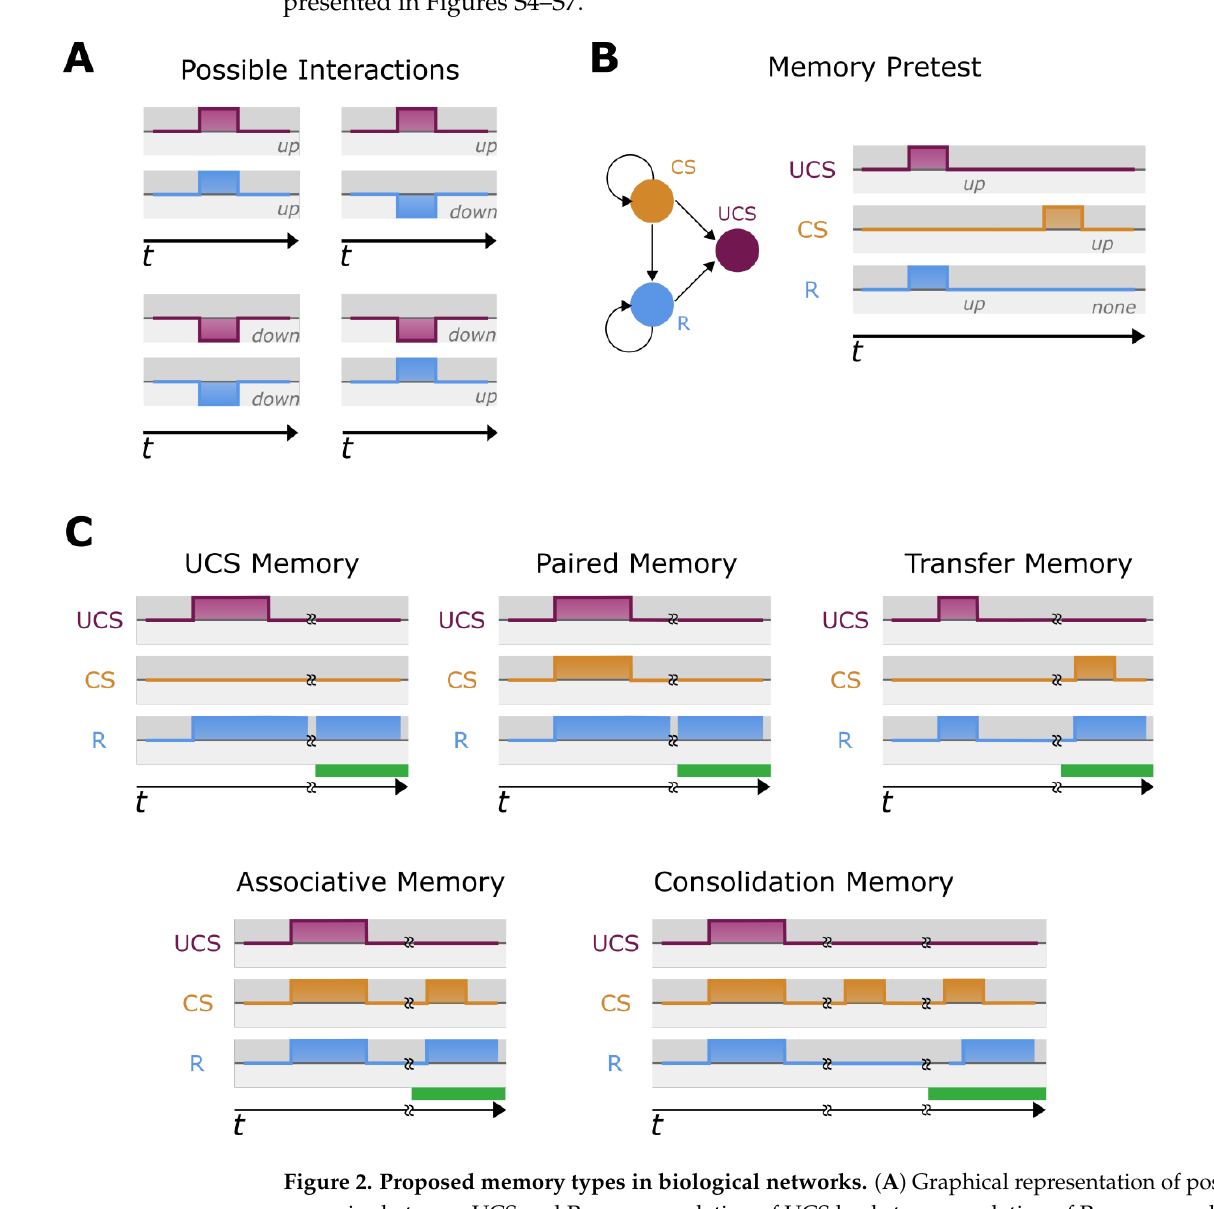
Figure 2. Proposed memory types in biological networks. ( A ) Graphical representation of possible scenarios between UCS and R; an upregulation of UCS leads to upregulation of R, an upregulation of UCS leads to downregulation of R, a downregulation of UCS leads to downregulation of R, or downregulation of UCS leads to upregulation of R. Note that stimulation may be either upregulation or downregulation. Likewise, a response may be upregulation or downregulation. Note that while all responses have the same intensity, this is for visualization only. ( B ) The memory pretest for each potential memory circuit. First, UCS is stimulated, and the R node checked for response. Second, the chosen CS node is stimulated, and the R node is checked to ensure no response occurs. If any of these tests fail, the potential memory circuit is rejected. ( C ) The five tested memory phenotypes for all potential memory tests that pass the pretest (see description in Section 4). While responses are shown to be simultaneous this is not the case in normal biomodels, and we note that in this way for visual clarity only. Colors are matched to node identity and colors in the area under the stimulation or response are for visualization. The green bar represents the ‘test period’, where the desired memory responses is searched for after a stimulation of